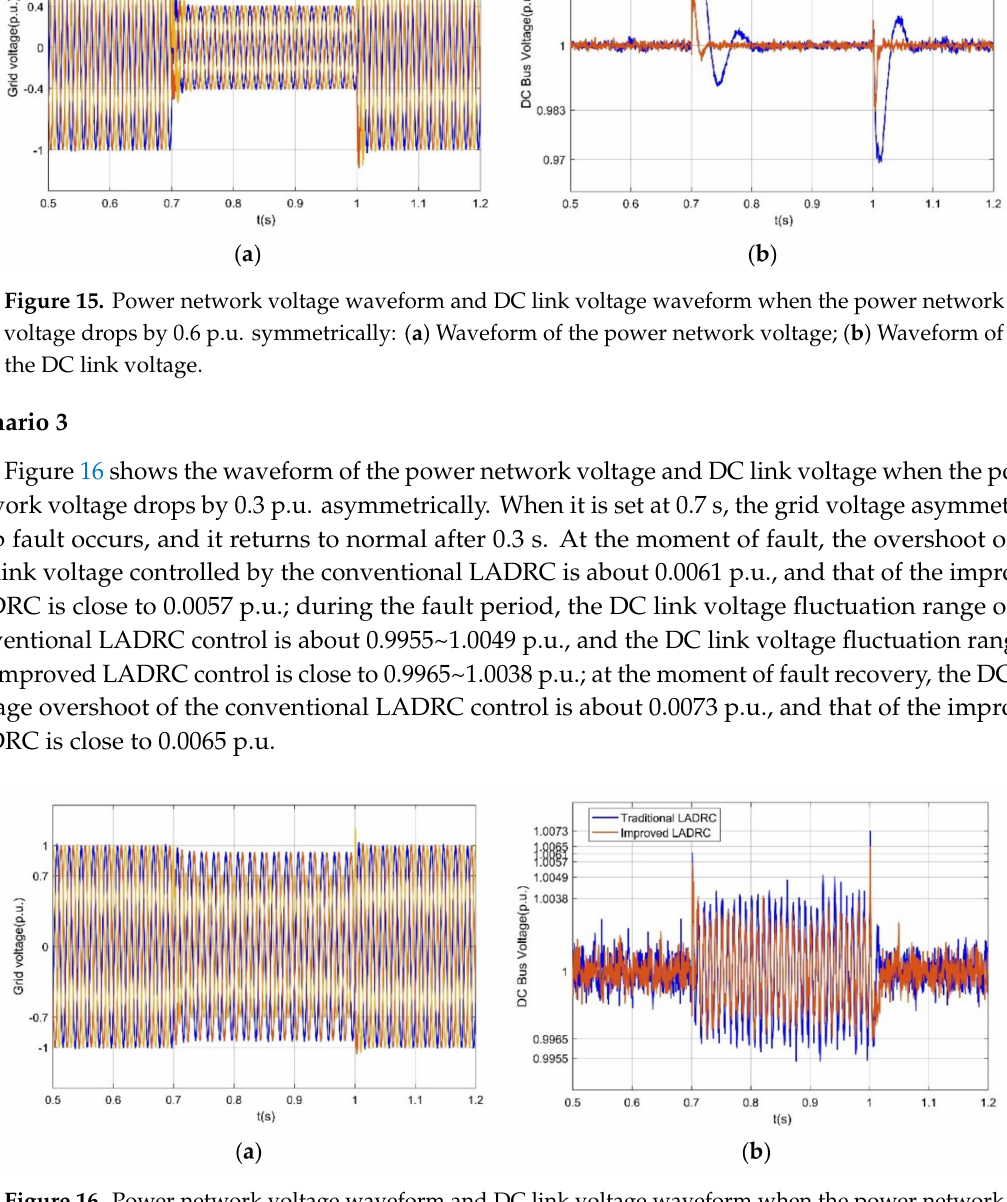
Figure 16. Power network voltage waveform and DC link voltage waveform when the power network voltage drops by 0.3 p.u. asymmetrically: ( a ) Waveform of the power network voltage; ( b ) Waveform of the DC link